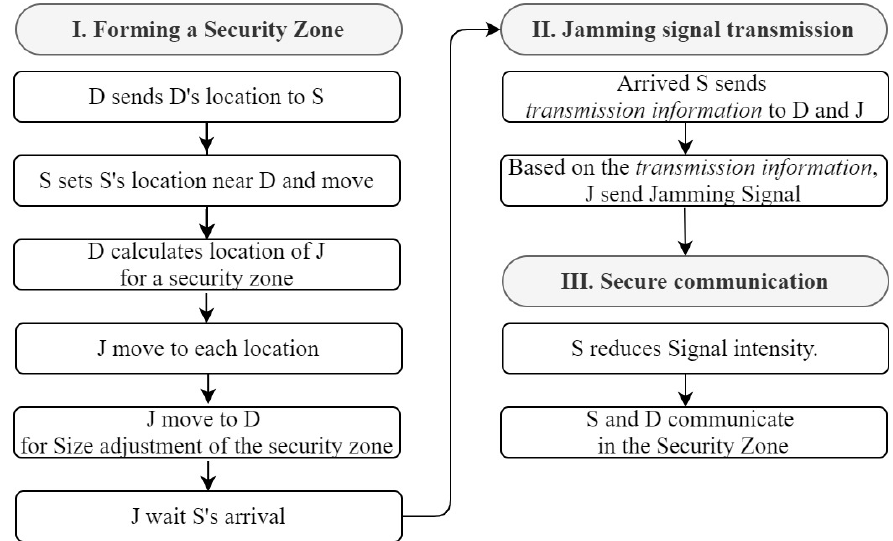
Figure 2. Simulation flow chart.